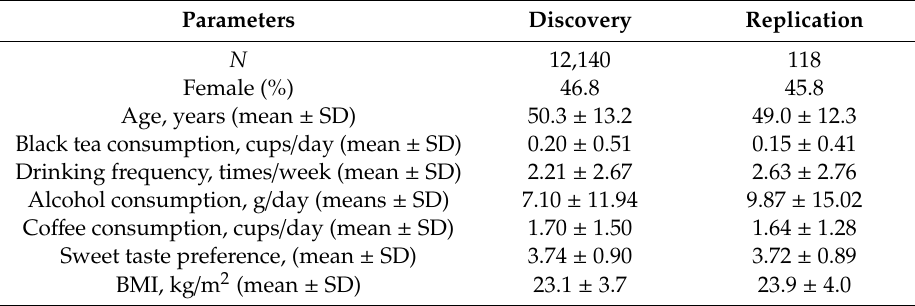
Table 1. Participant characteristics .